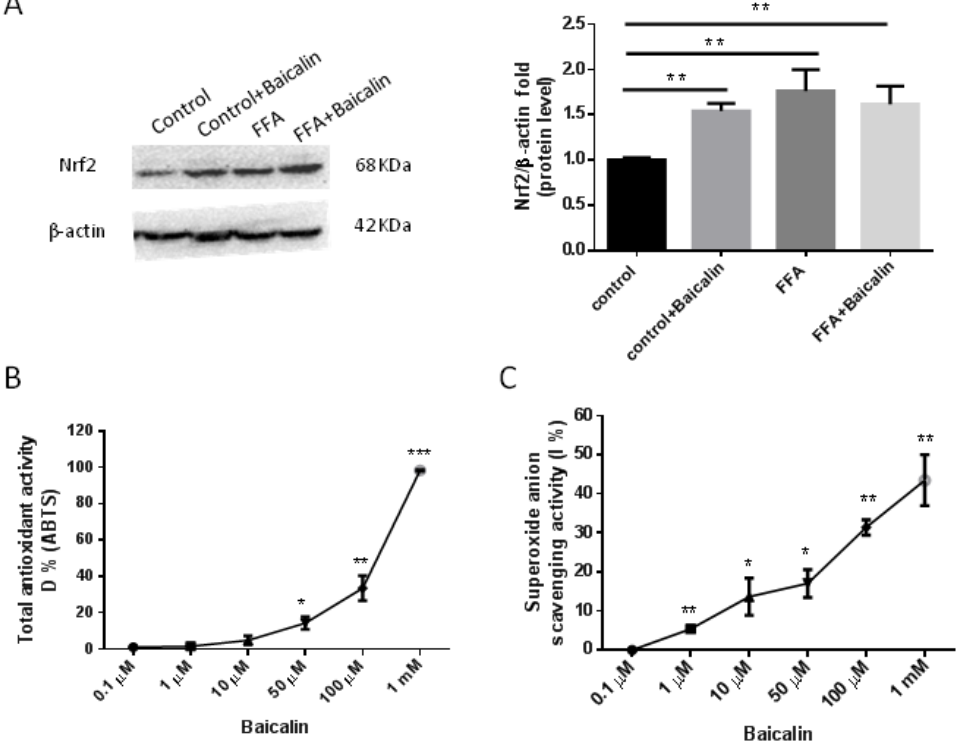
Figure 6. Antioxidant capacity of baicalin. ( A ) Representative Western blots for Nrf2 protein expres- sion and quantification in each group ( n = 6). ( B ) Total antioxidant capacity assessment by the ABTS method. ( C ) Superoxide anion scavenging activity assay. The concentrations of baicalin were from 0.1 μ M to 1 mM. Duplicate experiments were repeated three times. All the values were compared with controls (0 μ M baicalin), * p < 0.05; ** p < 0.01; *** p < 0.001.